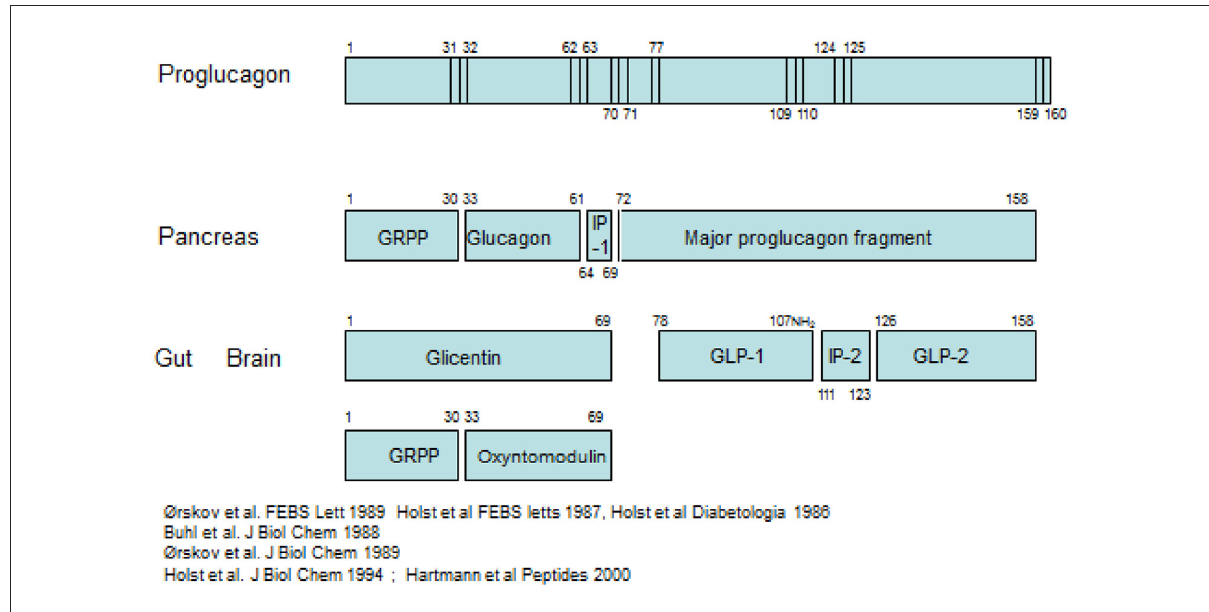
FIGURE1 Processing of proglucagon in the pancreas and the